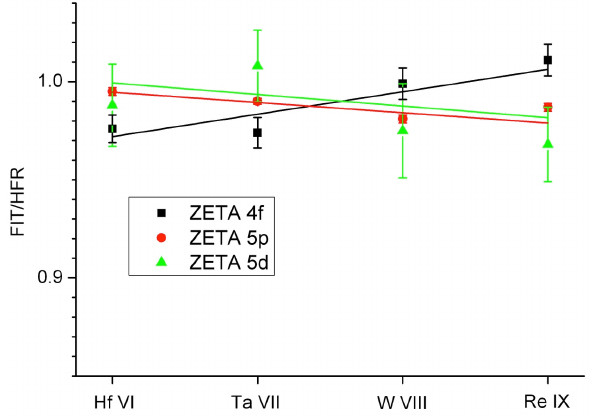
Figure 7. Scaling factors for spin-orbit parameters (ZETA) in the even